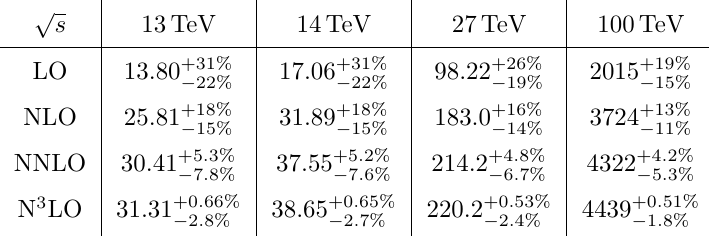
p s from LO to N 3 LO. The quoted